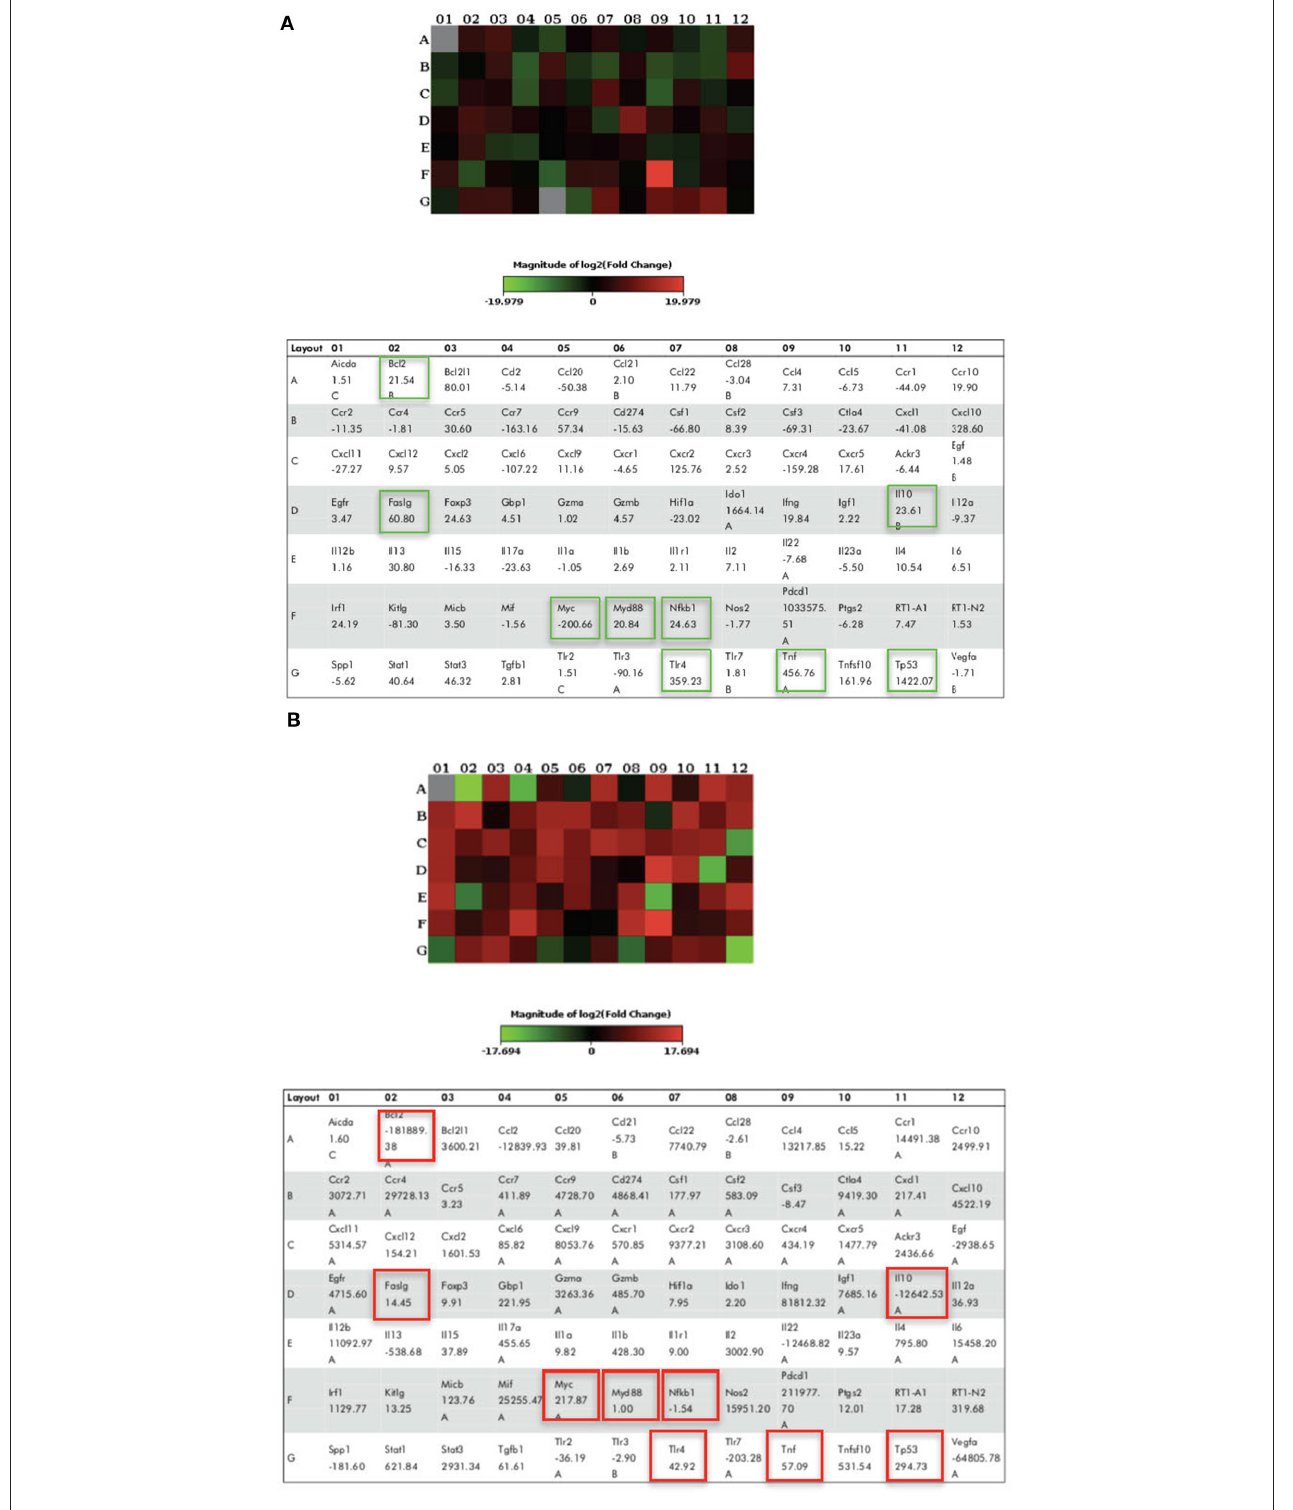
FIGURE 23 | The Heat Map array provides visualization of fold changes in expression. (A) The fold changes in expression between LPS-induced and LPS-preconditioned cells (in green) for every gene in the array in the context of the array layout of three independent experiments. (B) The fold changes in expression between LPS-induced cells and LPS-induced cells with caspase inhibitors (in red) for every gene in the array in the context of the array layout of three independent experiments. The table provides the fold regulation data used for the map.